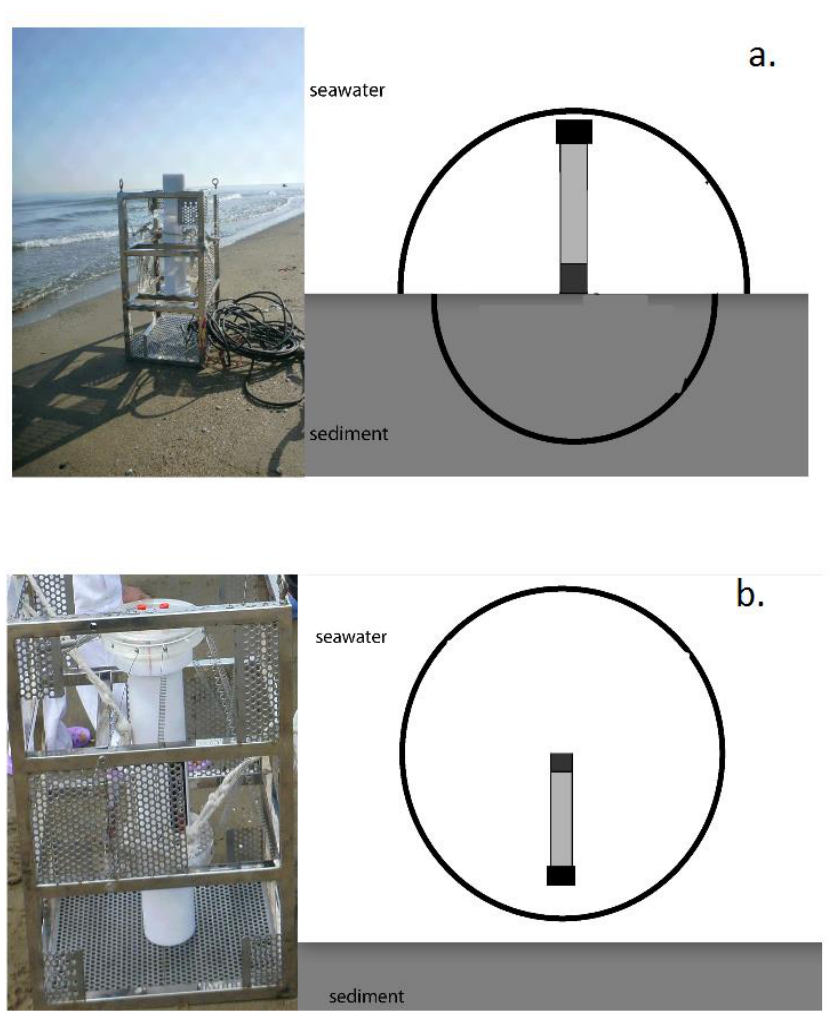
Figure 2. Schematic diagram and the underwater photo of the experimental setup in the seawater ( a ) and in the sediment ( b ).